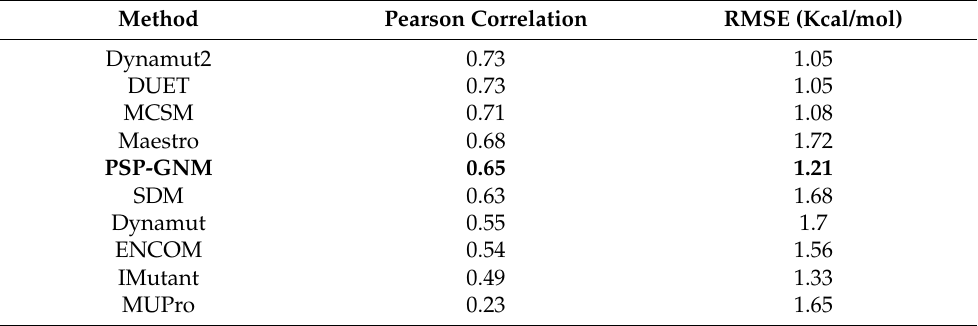
Table 4. Performance on the S350 dataset for a subset of 89 mutations with a PSP-GNM-calculated ∆∆ G and with experimental temperatures ranging from 24 ◦ C to 26 ◦ C and pH ranging from 6.8 to 7.2. The 89 mutations had at least one contact broken, both in the wildtype and mutant forms, for the residue at the mutation position when simulating unfolding with PSP-GNM. The performance for PSP-GNM is shown in bold.